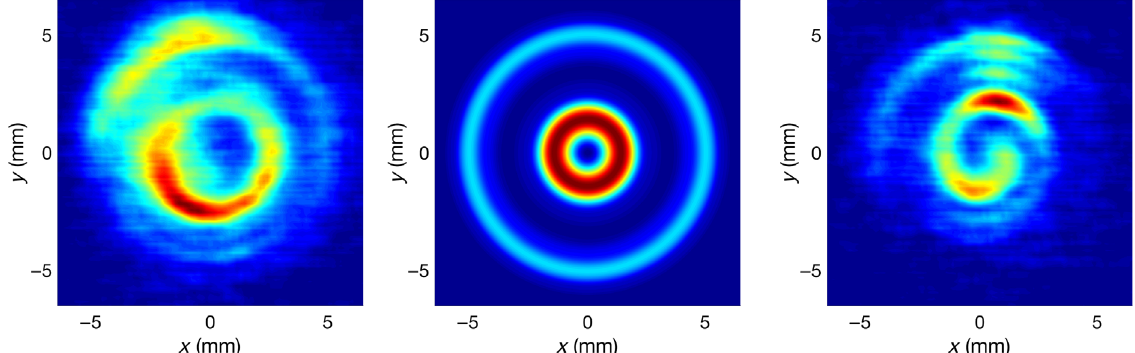
FIG. 3. Left panel: A typical single-shot image of an optical vortex generated at 15.6 nm. The multiple-ring pattern comes from the interference of the emission from six undulators. Middle panel: Calculation. Right panel: A single-spiral pattern obtained by interference of the optical vortex with a Gaussian mode (in a single-shot measurement), confirming the l ¼ 1 charge of the vortex beam.